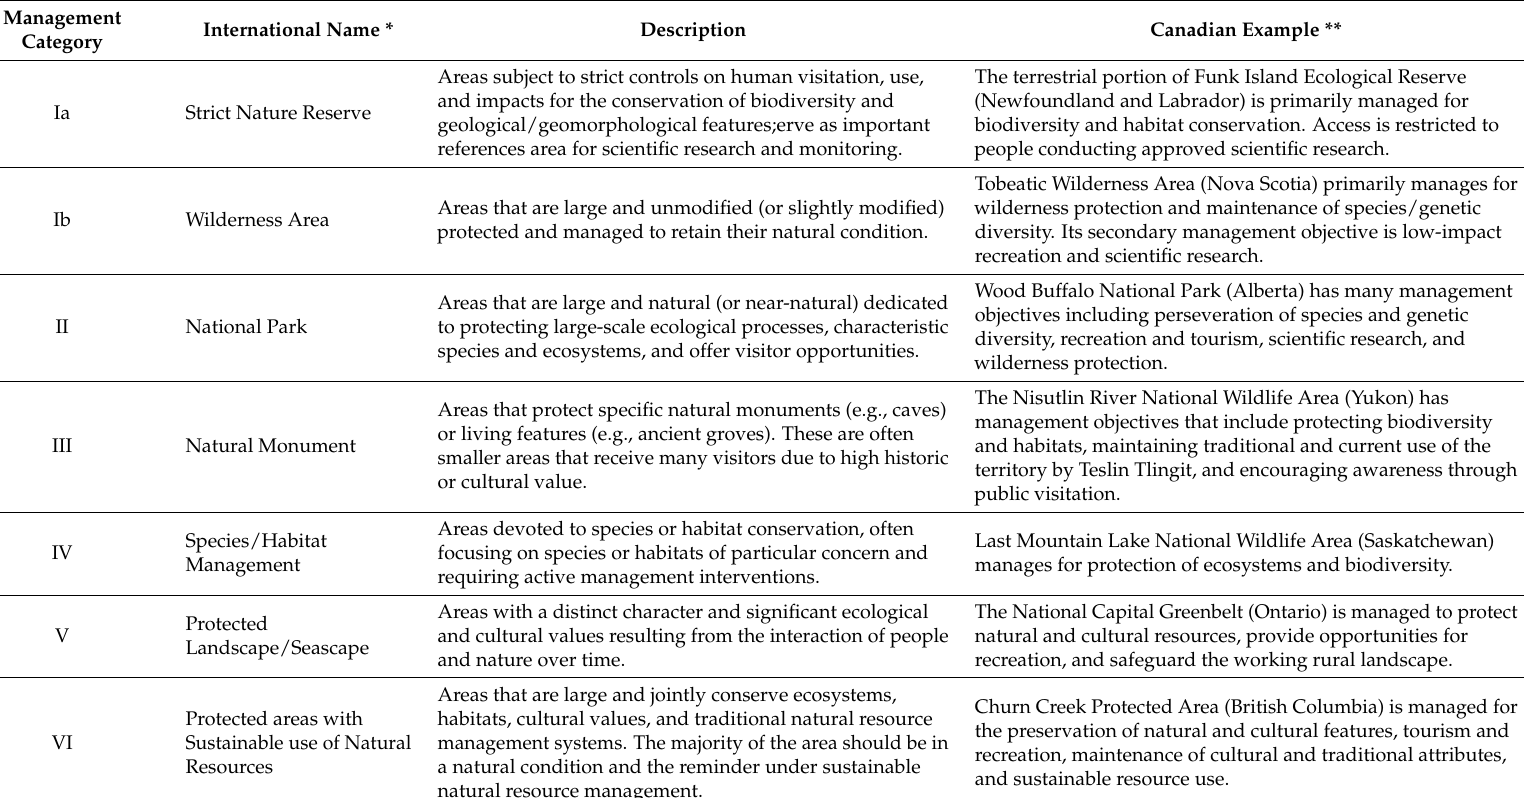
Table 3. IUCN management categories for protected areas with Canadian